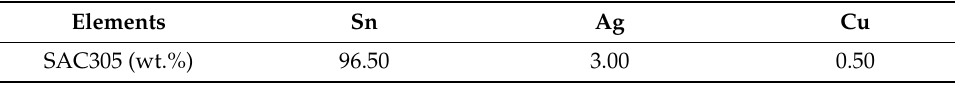
Table 1. The nominal composition of SAC305 solder alloy